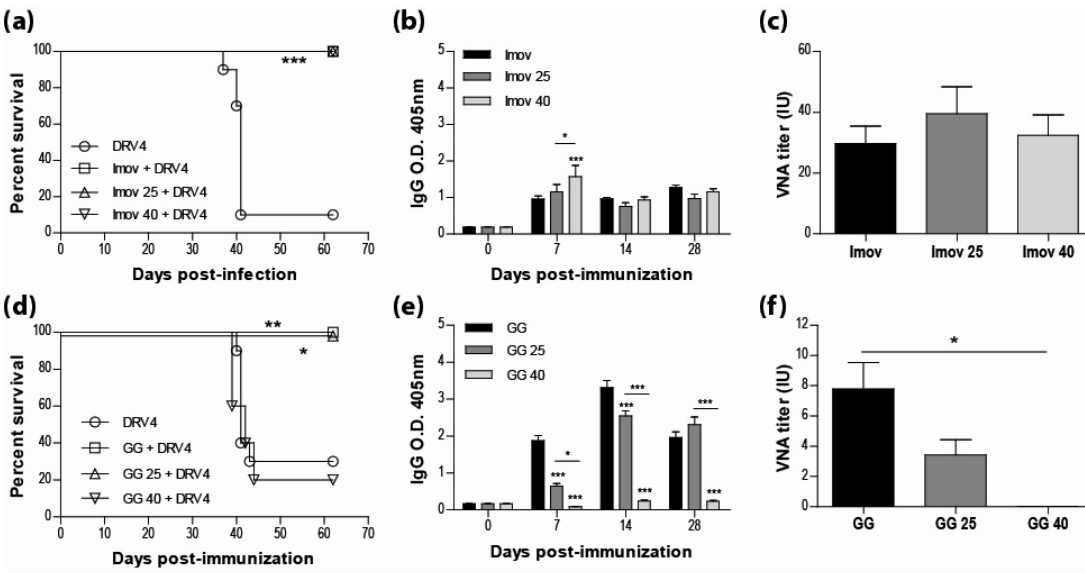
Figure 1. Live-attenuated RABV vaccines, stored at room temperature, retain sufficient infectivity to induce fully protective immunity. Swiss Webster mice were immunized with 0.25 IU of IMOVAX ® ( a ) or 1 × 10 5 f.f.u. of GG ( d ) i.m.g. stored at various temperatures then challenged 30 days later with 1 × 10 5 f.f.u. of DRV4 i.m.g. and monitored for survival. Data are expressed as percent survival ( n = 5–10 per group). ( b and e ) Virus-specific Ab response for total IgG was determined by ELISA at 7, 14